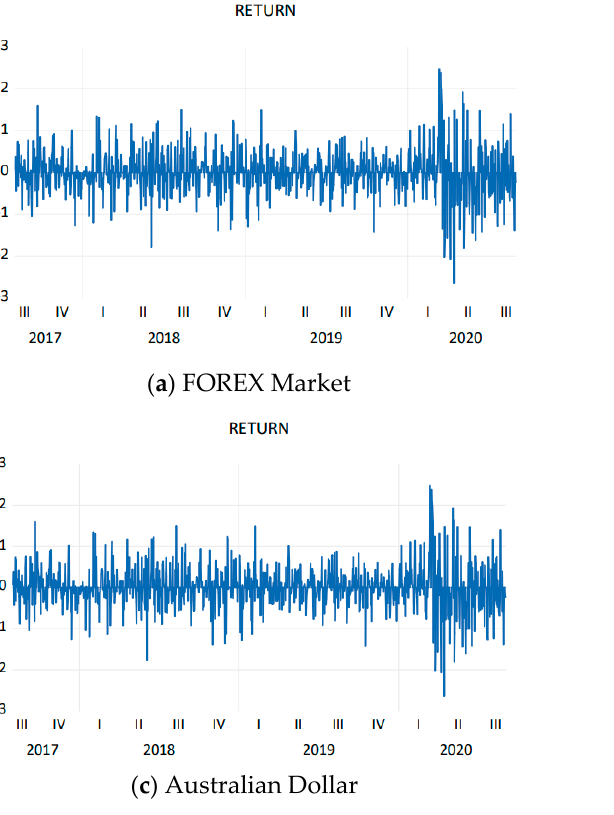
Table 4. Estimated Result of GARCH (1,1) Models.